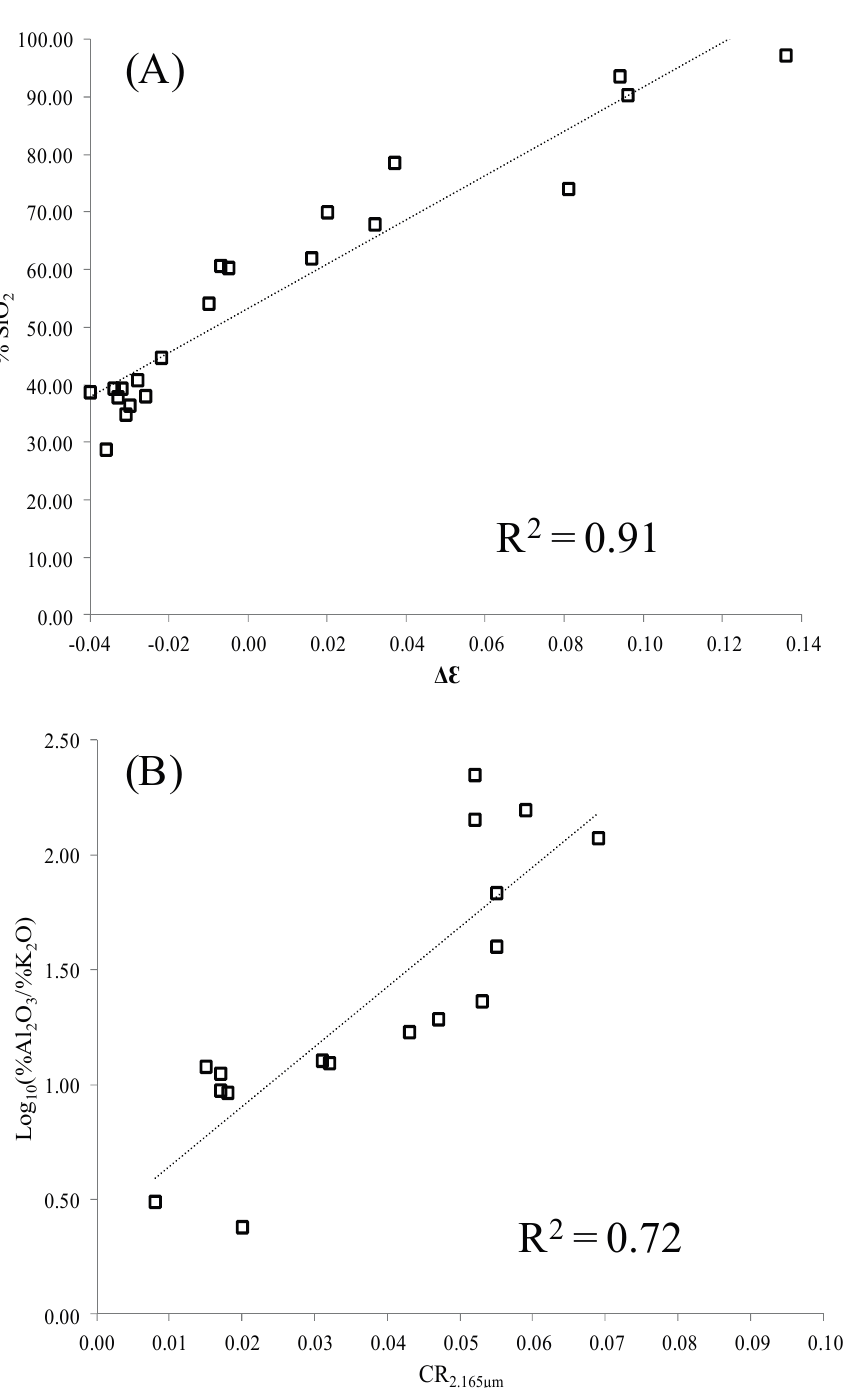
values and the calculated ΔԐ 2 (%Al O /%K O) values and the 10 2 3 2